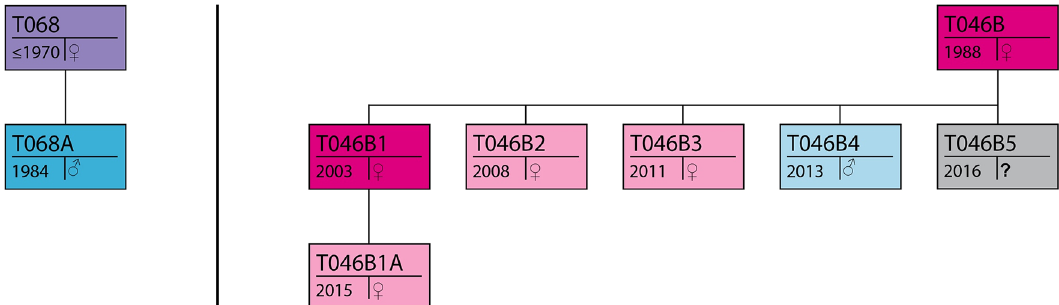
Figure 2. Geneological schematic of present individuals. The identities and where known, sex and birth year of all whales present and their maternal relations to each other (see original schematics in Towers et al . 30 ) displayed in colour coded statuses. Purple: post-reproductive female, Blue: reproductive male, Fuscia: reproductive females, Pink: juvenile females, Light Blue: juvenile male, Gray: neonate of unknown